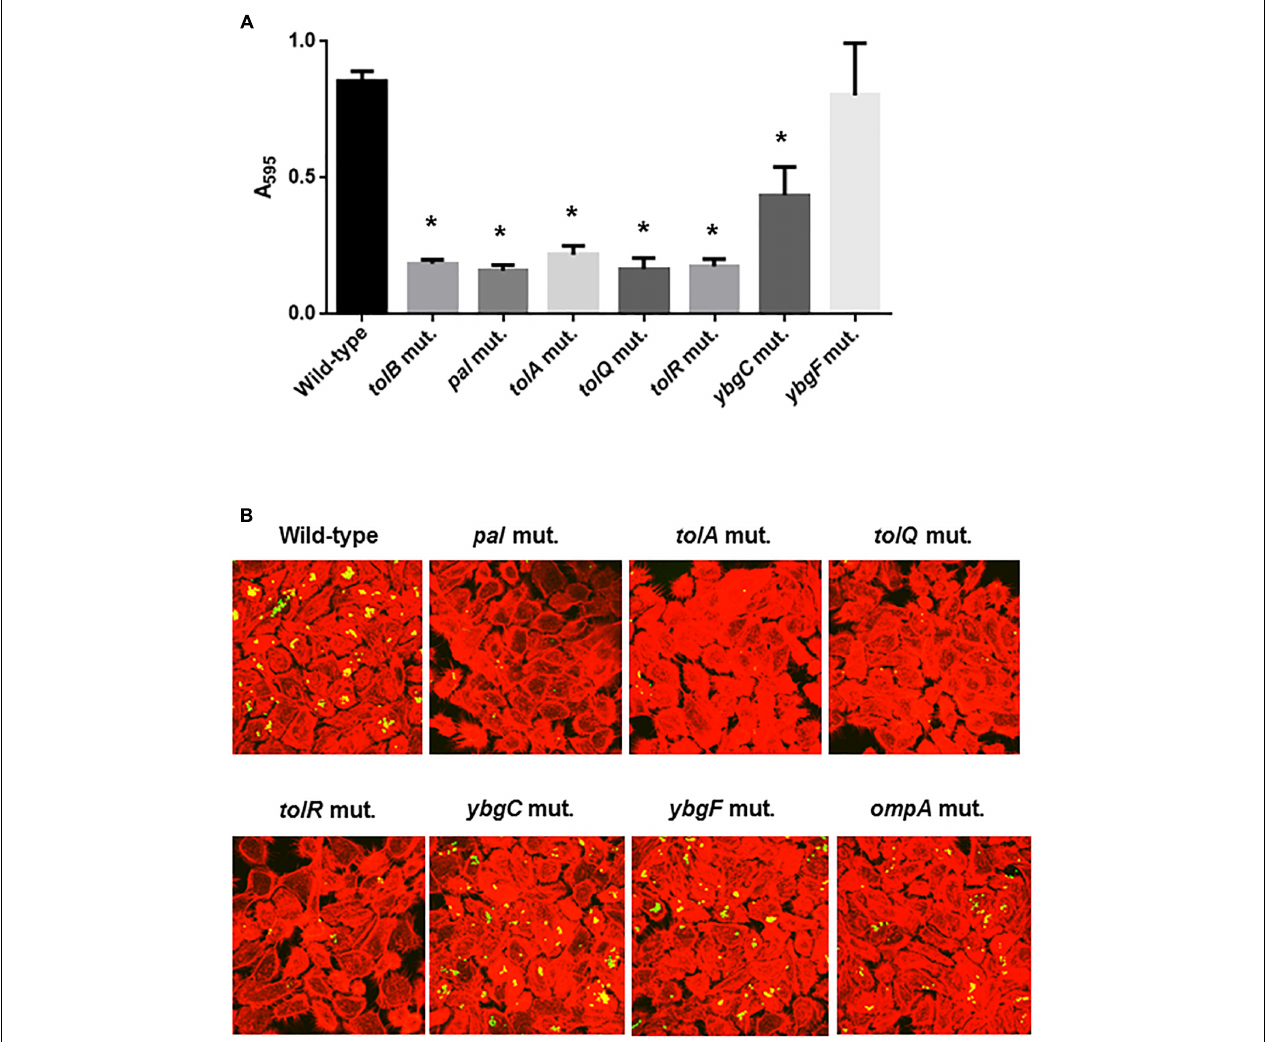
FIGURE 7 | Bacterial adhesion and aggregation on 96-well polystyrene plates in the wild-type parent, and the tol - pal , ybgC , ybgF , and ompA mutants (A) . Bacterial adhesion and aggregation were represented as A 595 values normalized to OD 600 of 1. Data plotted are the means of three biological replicates, error bars indicate the ranges, ∗ P < 0.01. Asterisks denote significance for values relative to the wild-type control. Fluorescent images of aggregated UPEC cells within bladder epithelial cells (HTB-9) (B) . Bacteria carrying a Green fluorescence protein (GFP) expression plasmid, pTurboGFP-B and HTB-9 stained with rhodamine-phalloidin were imaged as, respectively, green and red fluorescent colors on the microscopy using 60 × objective. The experiment was repeated twice and similar results were obtained.